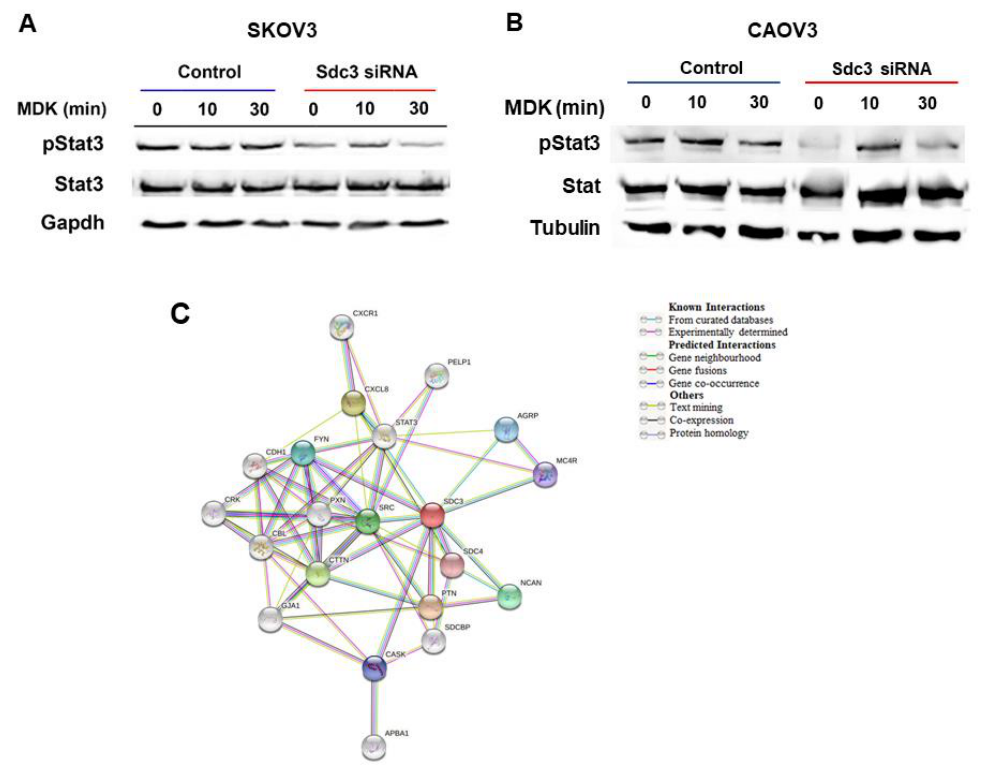
Figure 5. SDC3 siRNA#1 depletion in ( A ) SKOV3 and ( B ) CAOV3 cells results in reduced activation of Stat3. SKOV3 and CAOV3 cells were subjected to control or SDC3 siRNA#1 treatment, serum starved for 24 h and stimulated with 2 ng/mL of the cytokine Midkine (MDK) for the indicated timepoints. Cell lysates were subjected to Western blotting for the active, phosphorylated form of Stat3, total Stat3 and Gapdh as a loading control. SDC3 depletion reduces the constitutive activation of Stat3 in both cell lines. Representative blot from 3 experiments. Total Stat3 and Gapdh were detected on the same membrane after antibody stripping. ( C ) String analysis reveals direct functional interactions of SDC3 with SDC1 and Notch1 and indirect interactions with constituents of the stemness-associated Notch, Wnt and hedgehog pathways. Interaction analysis of SDC3 with SDC1, STAT3, the Notch pathway constituents NOTCH1 and HES1, the Wnt signaling constituents WNT5A and TCF7L1, the hedgehog pathway constituents GLI1 – 3, and the EMT-related markers E-cadherin (CDH1) and Snail (SNAI1) was performed using the STRING database (http://string-db.org/) (accessed on 4 June 2021).